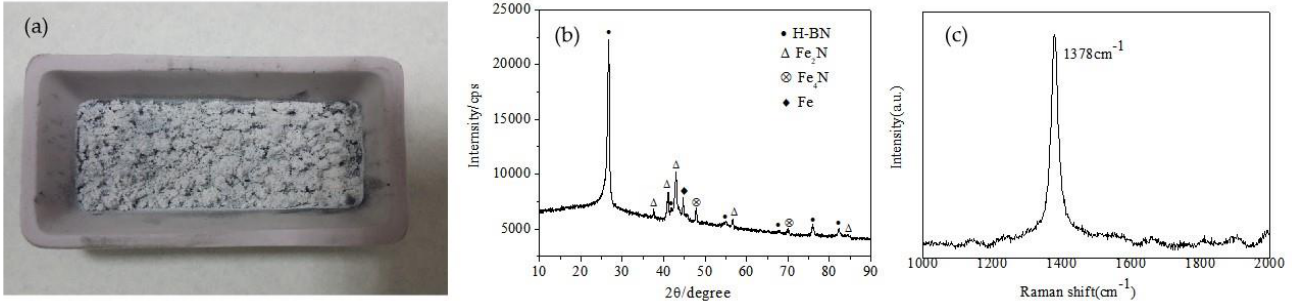
Figure 3. Optical image ( a ), XRD pattern ( b ) and Raman spectra ( c ) of the product.